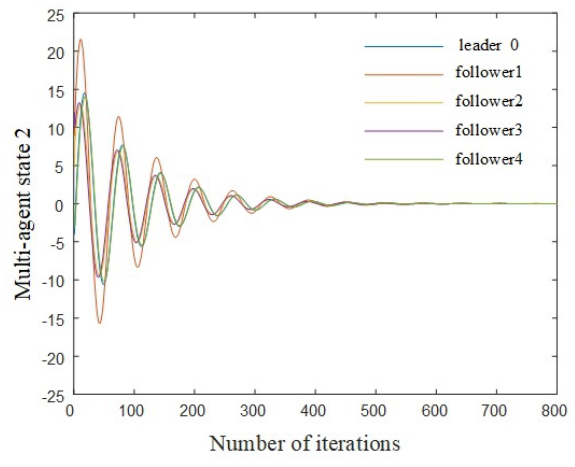
Fig. 6. Multi-agent state with limited time x i 1.